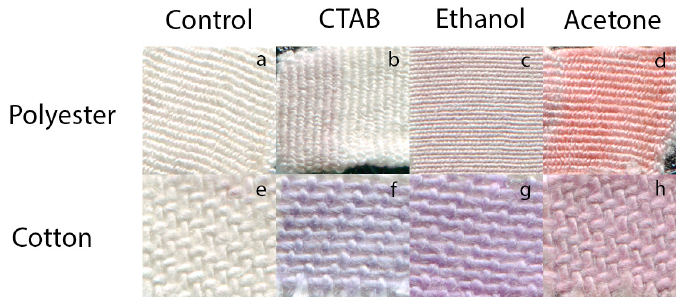
Figure 8. Printed fibers, including controls, showing color change in the dramada pigment. ( a ) Unprinted polyester; ( b ) Polyester printed with CTAB-based ink (pointed to by the purple arrow); ( c ) Polyester printed with ethanol-based ink; ( d ) Polyester printed with acetone-based ink; ( e ) Unprinted cotton; ( f ) Cotton printed with CTAB-based ink; ( g ) Cotton printed with ethanol-based ink; ( h ) Cotton printed with acetone-based ink.